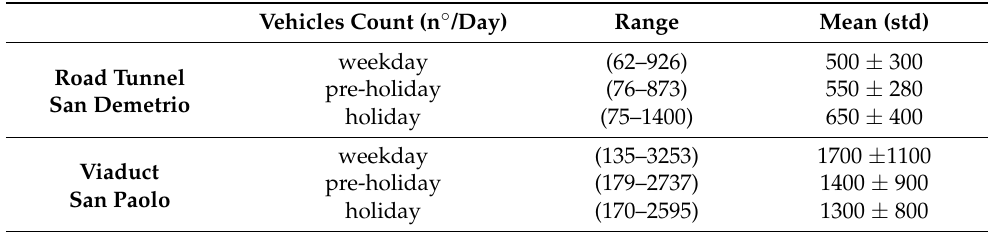
Table 4. Average number of vehicles counted in each day of the trimester for road tunnel and for Viaduct San Paolo in the trimester April–June.